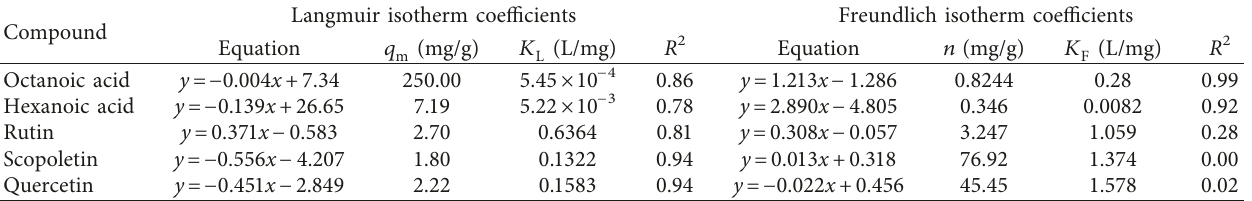
Table 8: Langmuir and Freundlich isotherm constants and correlation coefficients for octanoic acid adsorption by Amberlite IRA 67. Compound